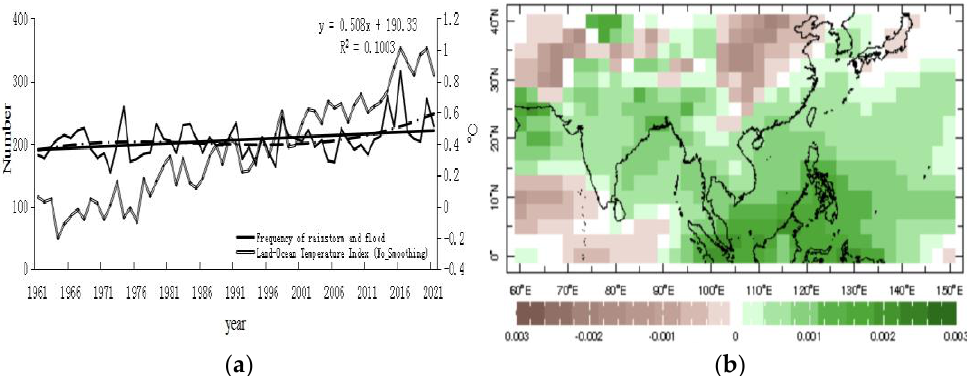
Figure 2. Trend analysis (thin solid line), polynomial fitting line (thick dashed line), linear trend line (thick solid line) and the Global Land–Ocean Temperature Index (hollow line) ( a ) and the linear trend of 850 hPa specific humidity ( b ) in the summer half-year during 1961–2021.